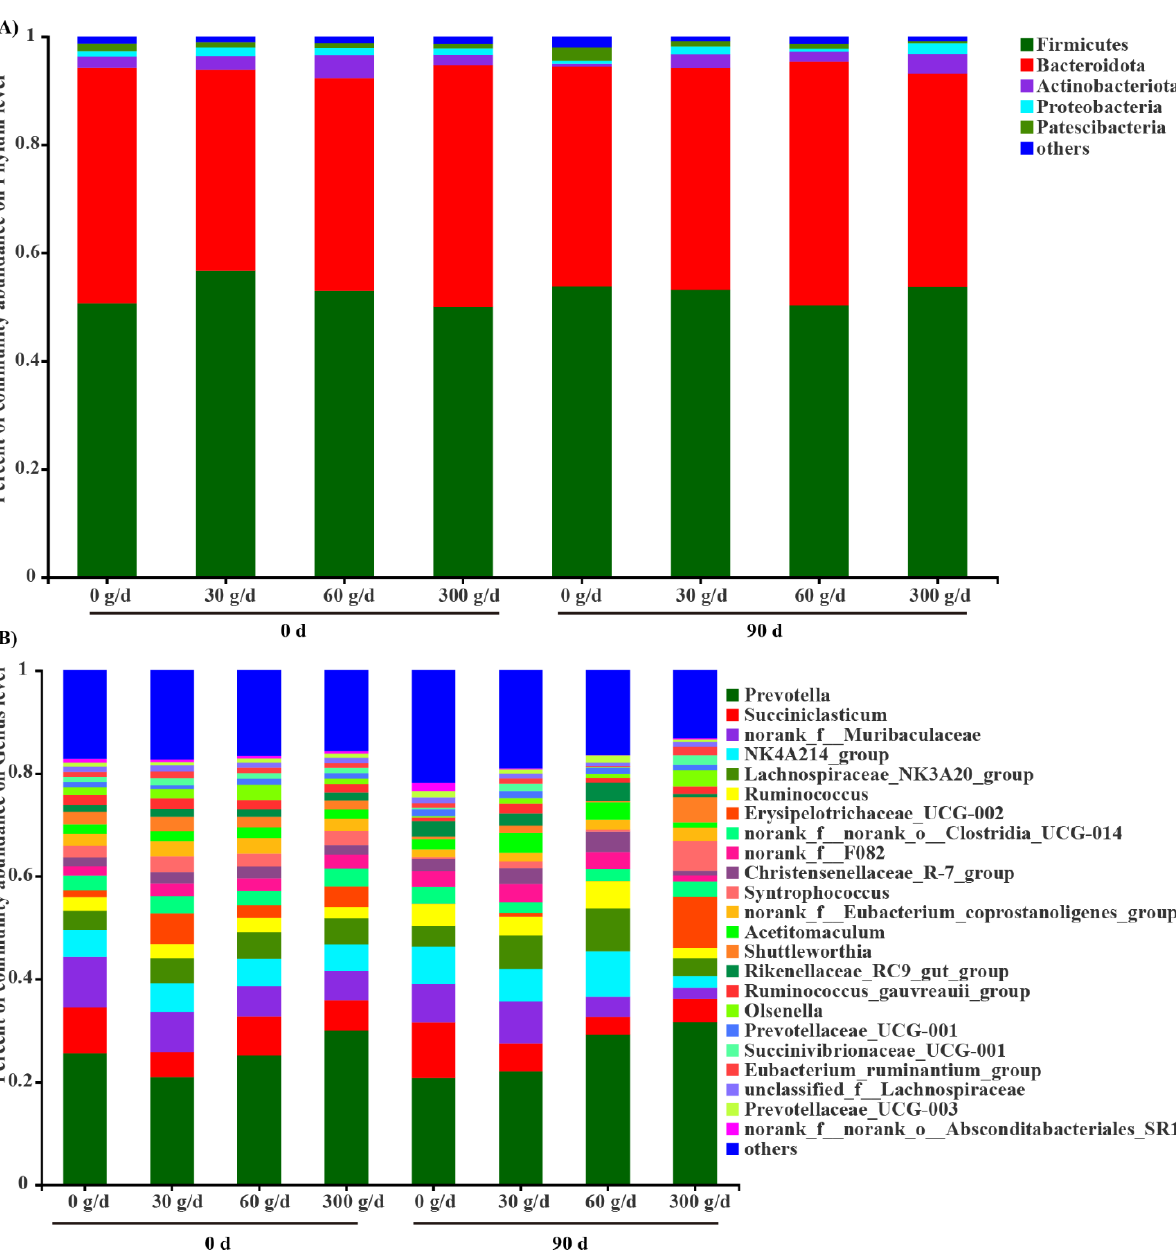
Figure 5. Composition of the rumen microbiota at the phylum level ( A ) and genus level ( B ) before (day 0) and after (day 90) of Acremonium terricola culture supplementation in lactating dairy cows. The relative abundance of taxa ≤ 0.01% belonged to others. n = 6 .